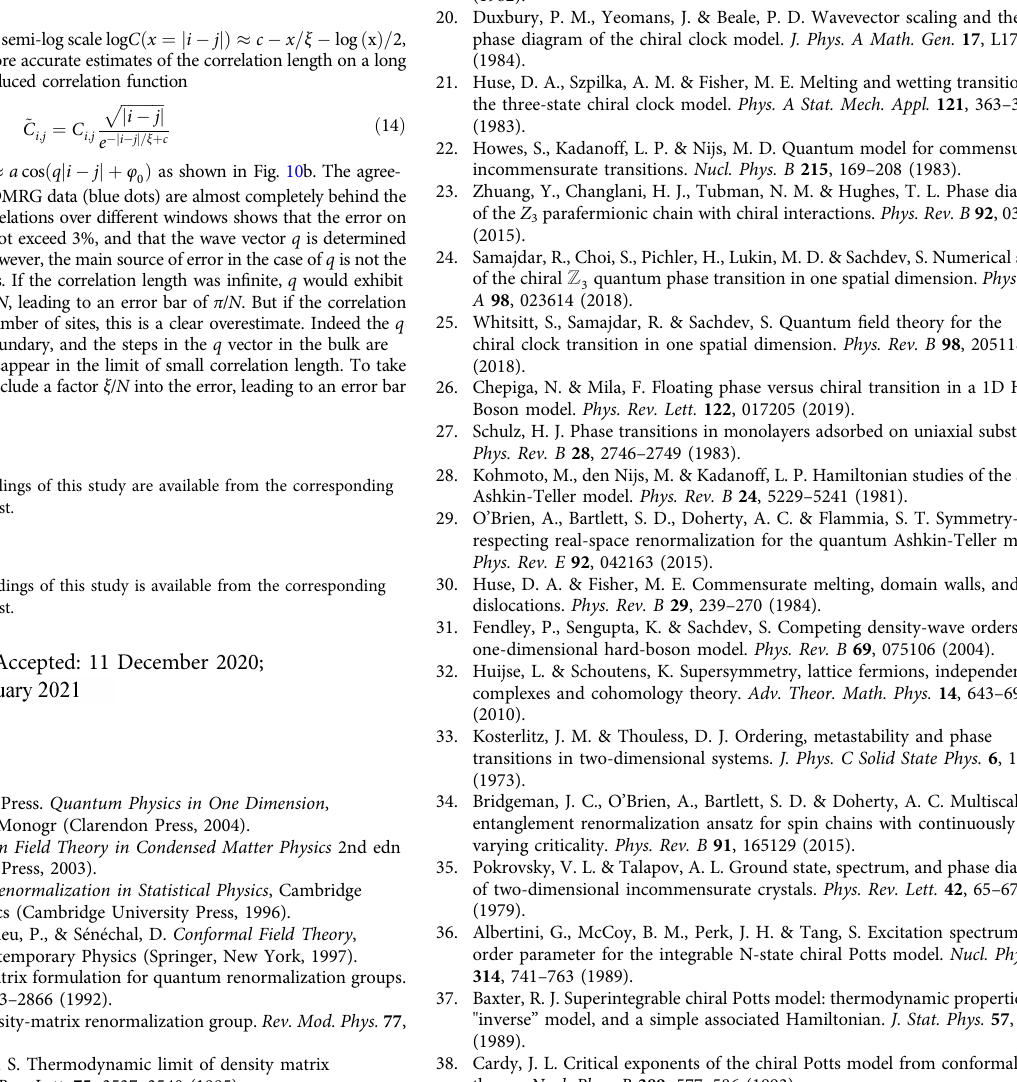
Fig. 10 Example of fi t of the correlation function to the Ornstein – Zernicke form. In the fi rst step a , we extract the correlation length discarding the oscillations. In the second step b , we fi t the reduced correlation function to extract the wave vector q